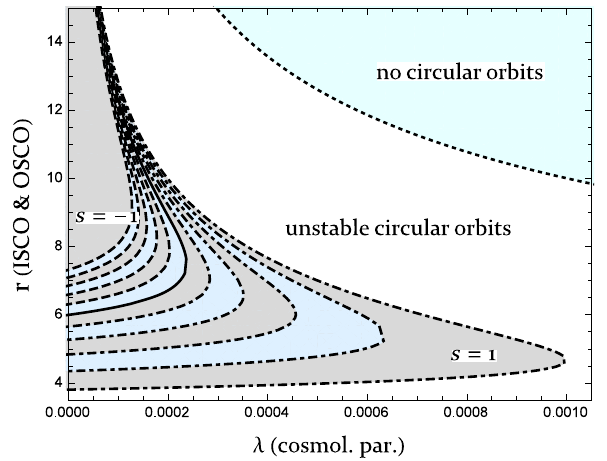
Fig. 2 Radii of marginally stable circular orbits as a function of the cosmological parameter λ for different values of the spin of the test particle. For a given value of λ the intersection with the lower (upper) part of the curve determines the ISCO (OSCO). Dashed, solid, and dotdashed curves correspond to the cases of spinning particle with neg- ative ( s < 0), zero ( s = 0), and positive ( s > 0) spins. The dotted curve represents the static radius. The shaded regions correspond to regions where stable circular orbits can exist, while in the white region between OSCOandthestaticradiuscircularorbitsexistbutareunstable.Beyond the static radius (in cyan region), circular orbits cannot